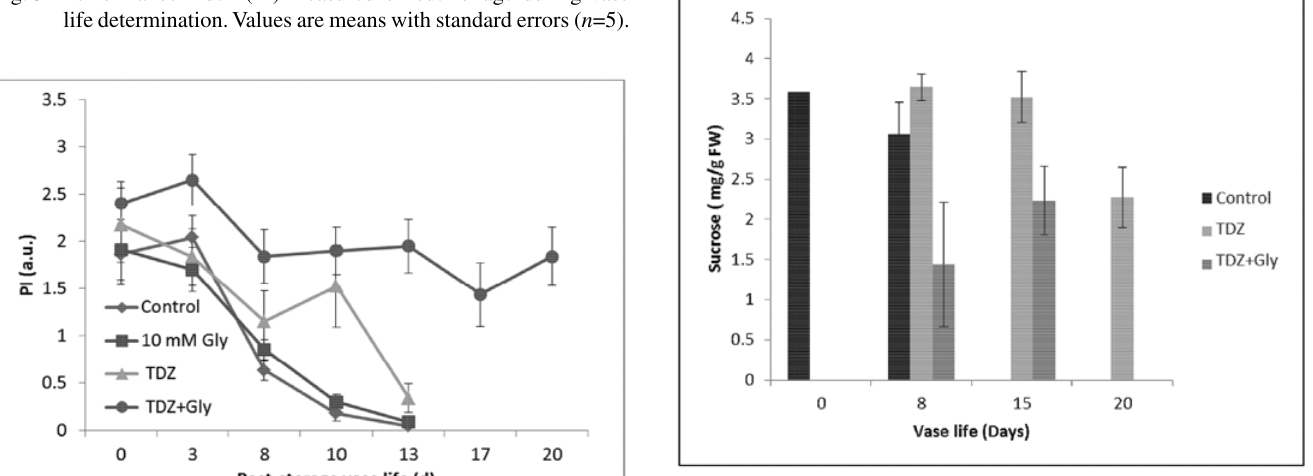
Fig. 4 - Performance index (PI) measured on cut foliage stored for 60 days and then transferred to 20 °C for vase life determination. Values are means with standard errors ( n =5).